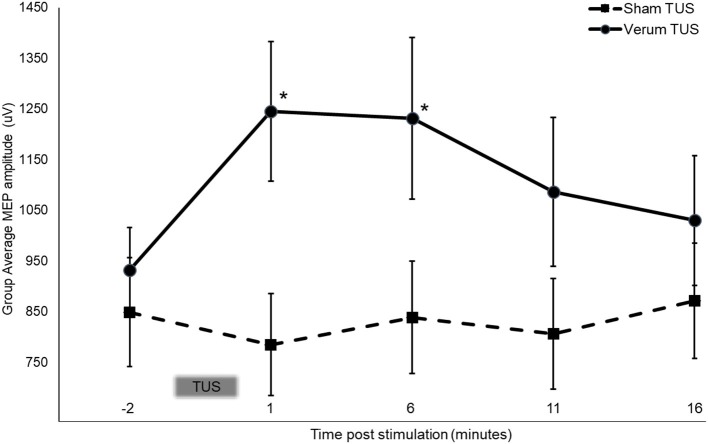
Stimulation dependent changes in MEP amplitude at baseline and following 2 min of tUS. Asterisks indicate significant between group differences (two-tailed t-test, independent samples, P < 0.05) Error bars = ±SE.